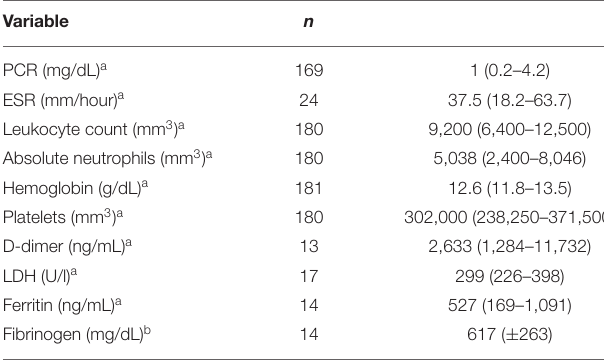
TABLE 3 | Laboratory tests performed on patients with COVID-19